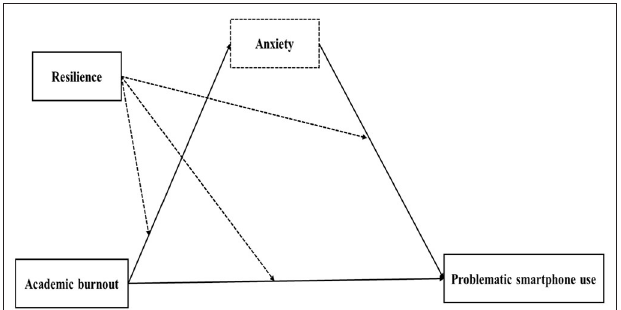
FIGURE 1 | The hypothesized model. The dotted boxes contained the investigated mediator and the dotted lines indicated the investigated moderation